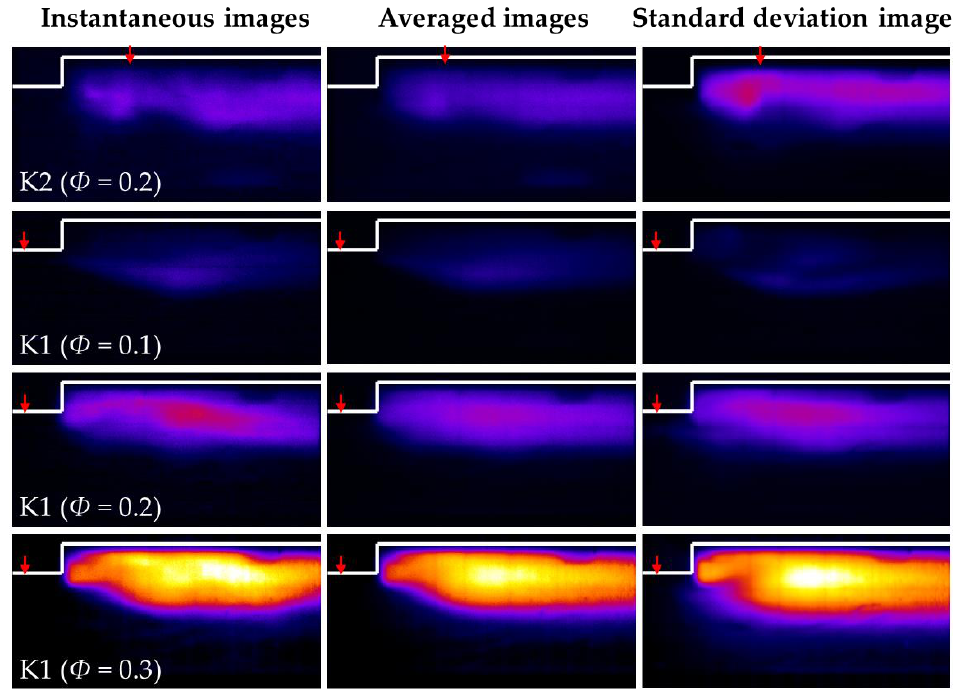
Figure 2. Instantaneous, averaged and standard deviation images of flame chemiluminescence.